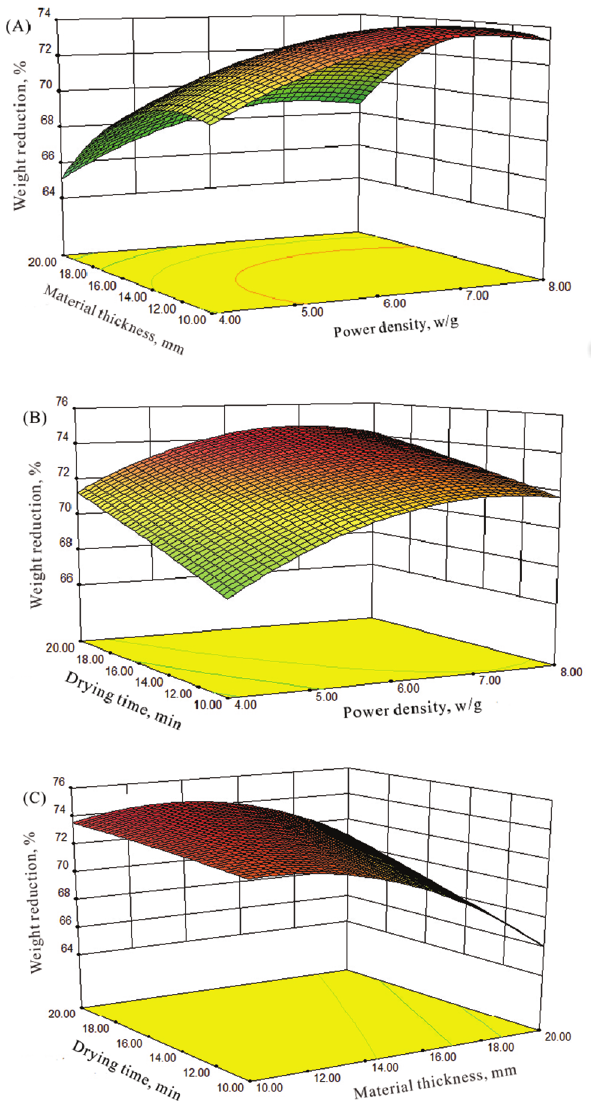
Figure 4: Response surface plot for weight